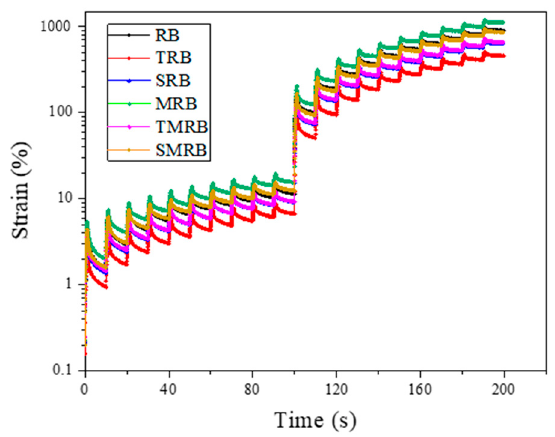
Figure 12. Multiple stress creep recovery (MSCR) test loading results of rubberized bitumen at stress levels of 0.1 and 3.2 kPa. Table 3. J nr and P obtained from the MSCR